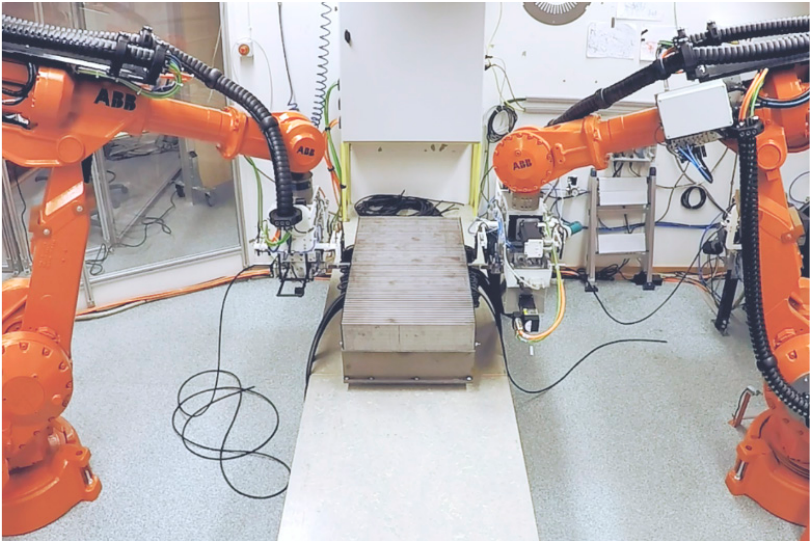
Figure 1. Robotized stator cable winding validated in full scale on a linear wave energy converter generator stator at UU in 2017, photo from [27].